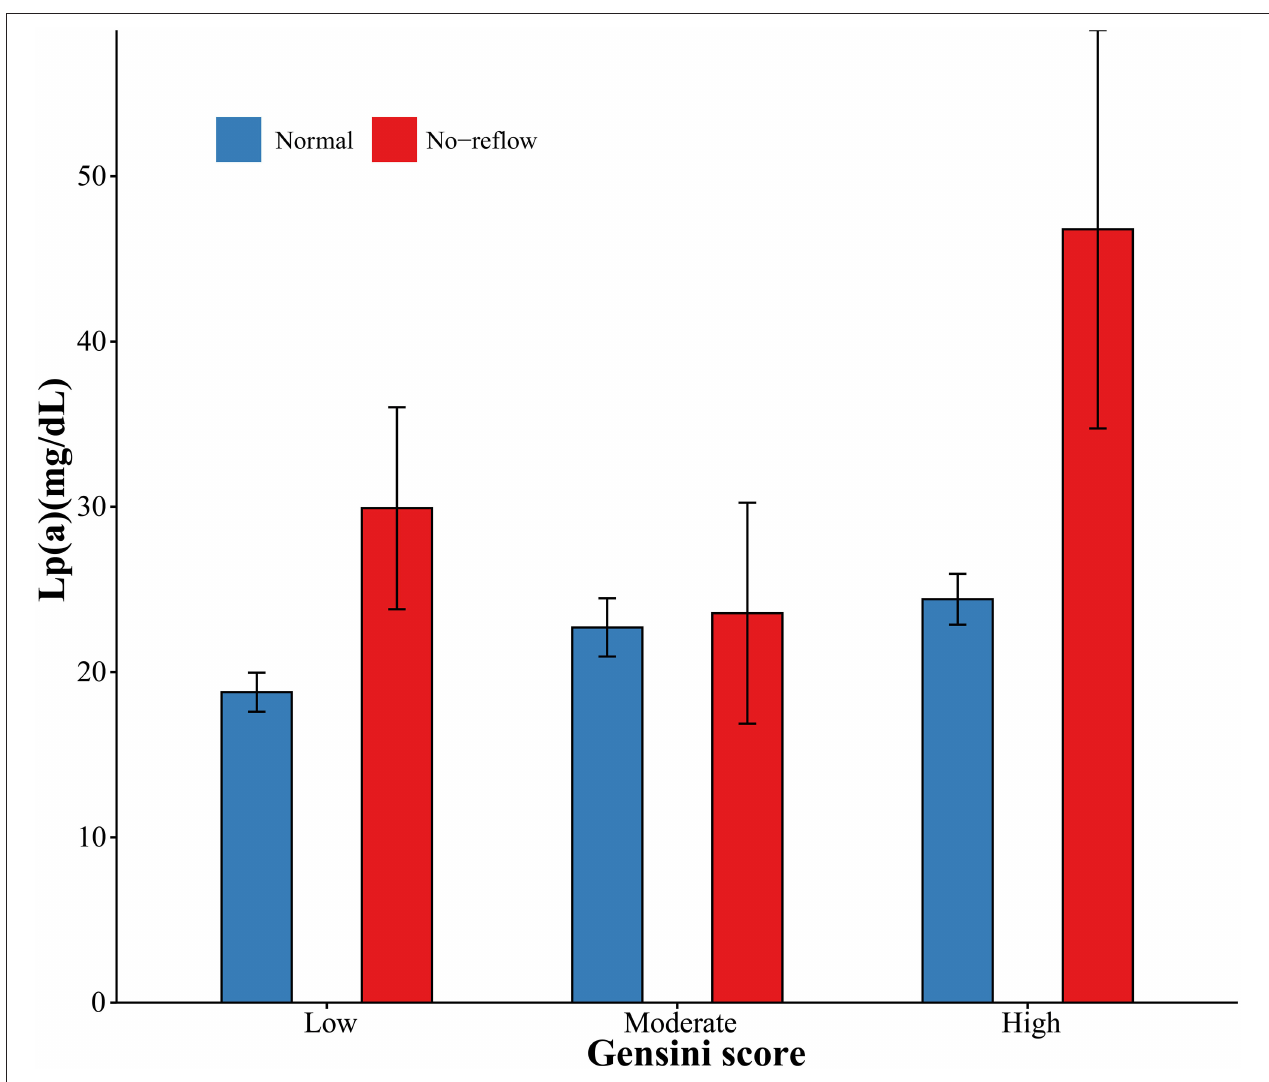
FIGURE 1 | Levels of lipoprotein (a) with respect to Gensini scores and